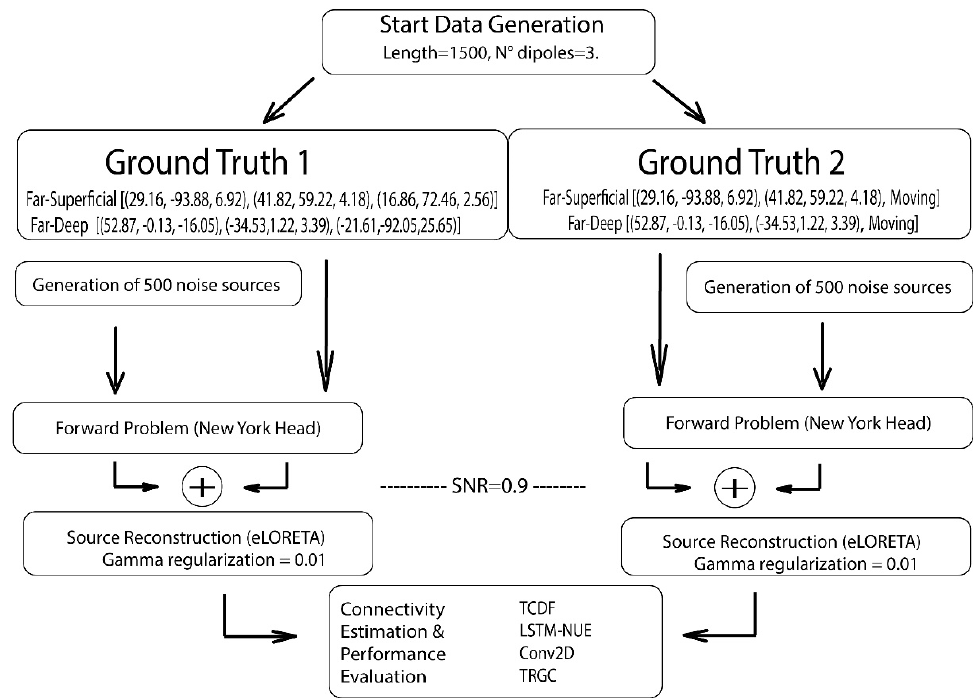
Figure 1. Simulation Procedure followed by Connectivity Estimation. TCDF = Depthwise Separable 1D Temporal Causal Discovery Framework, LSTM-NUE = Long Short-Term Memory with Non- Uniform Embedding, Conv2D = 2D Convolutional Network, TRGC = Time-Reversed Granger Cau- sality. Coordinates in the Ground Truths denote MNI-coordinates.